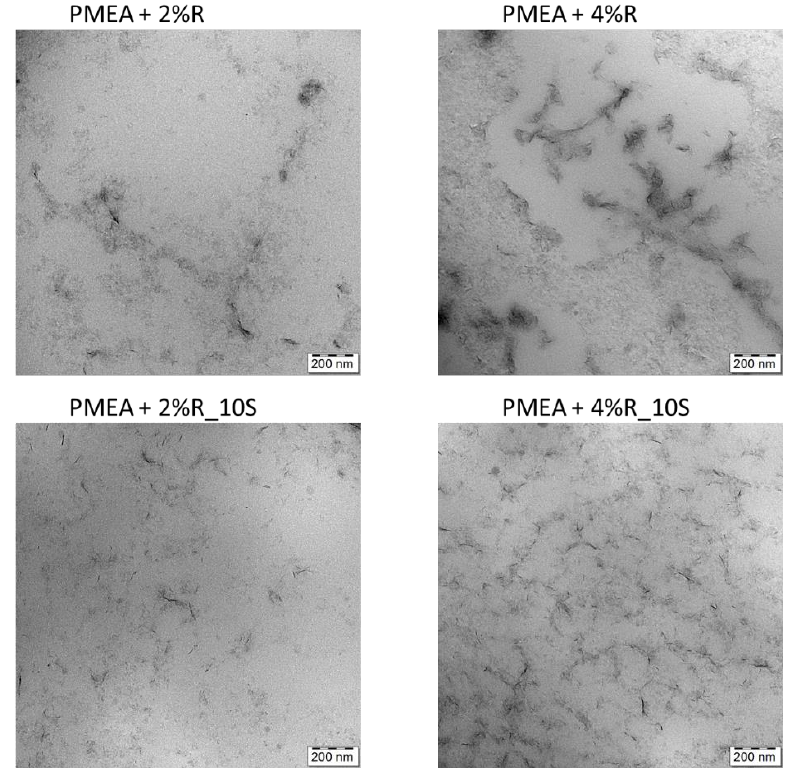
Figure 3. Morphology of exemplary important compositions of the studied nanocomposites; high- resolution TEM micrographs of all the studied materials are shown in Figures S1 – S3. resolution TEM micrographs of all the studied materials are shown in Figures